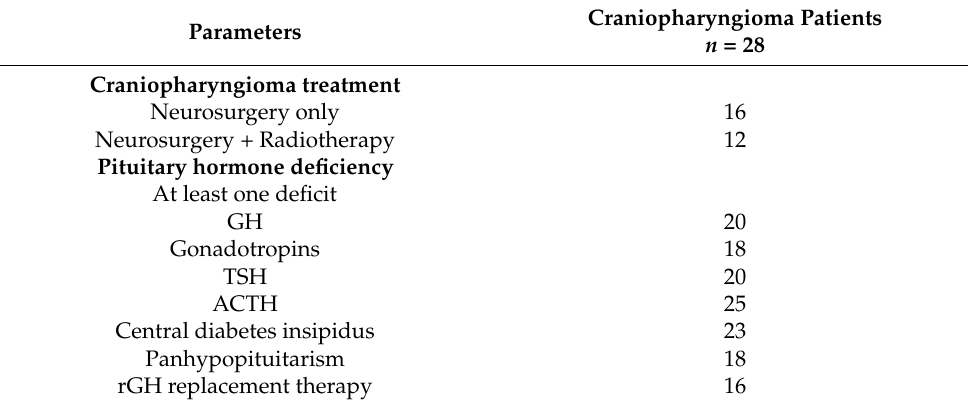
Table 1. Craniopharyngioma patients’ characteristics at study entry. Craniopharyngioma Patients Parameters n = 28 Craniopharyngioma treatment Neurosurgery only 16 Neurosurgery + Radiotherapy 12 Pituitary hormone deficiency At least one deficit GH